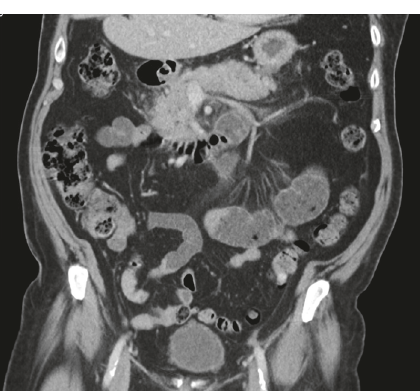
Figure 1: Coronal contrast enhanced CT image showing a homogenously enhancing bulky pancreas with peripancreatic haziness (arrows) with no evidence of collections consistent with noncomplicated acute interstitial